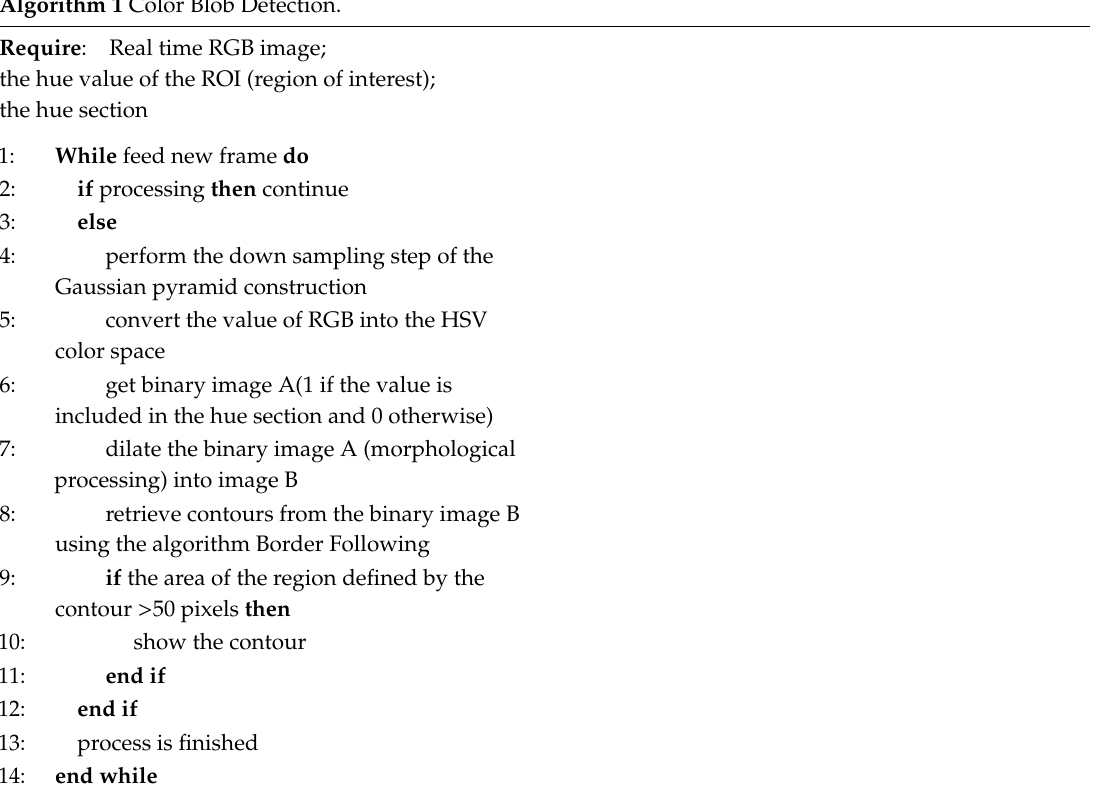
Algorithm 1 Color Blob